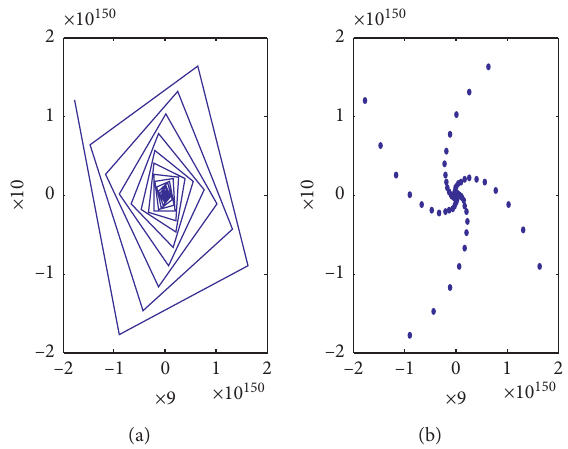
Figure 38: ω � 273 and k � 0 with the smoothed Coulomb model when t ∈ 0 . 05 0 . 0597 􏼂 􏼃 . w